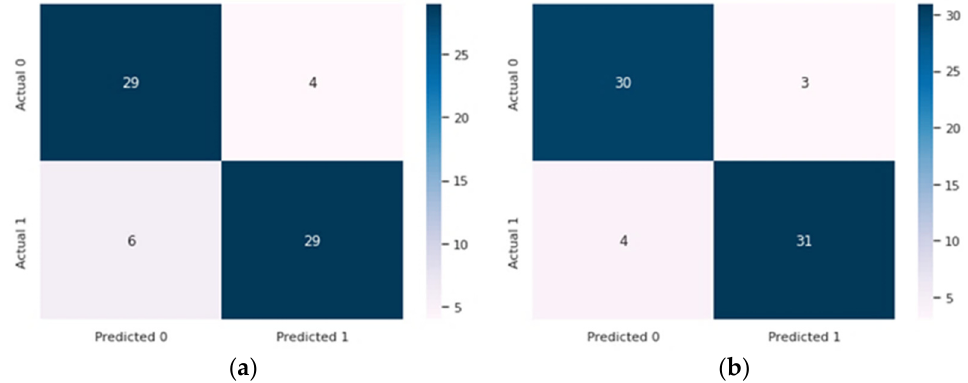
Figure 10. Confusion matrix of Statlog dataset. ( a ) Total features; ( b ) Selected features.